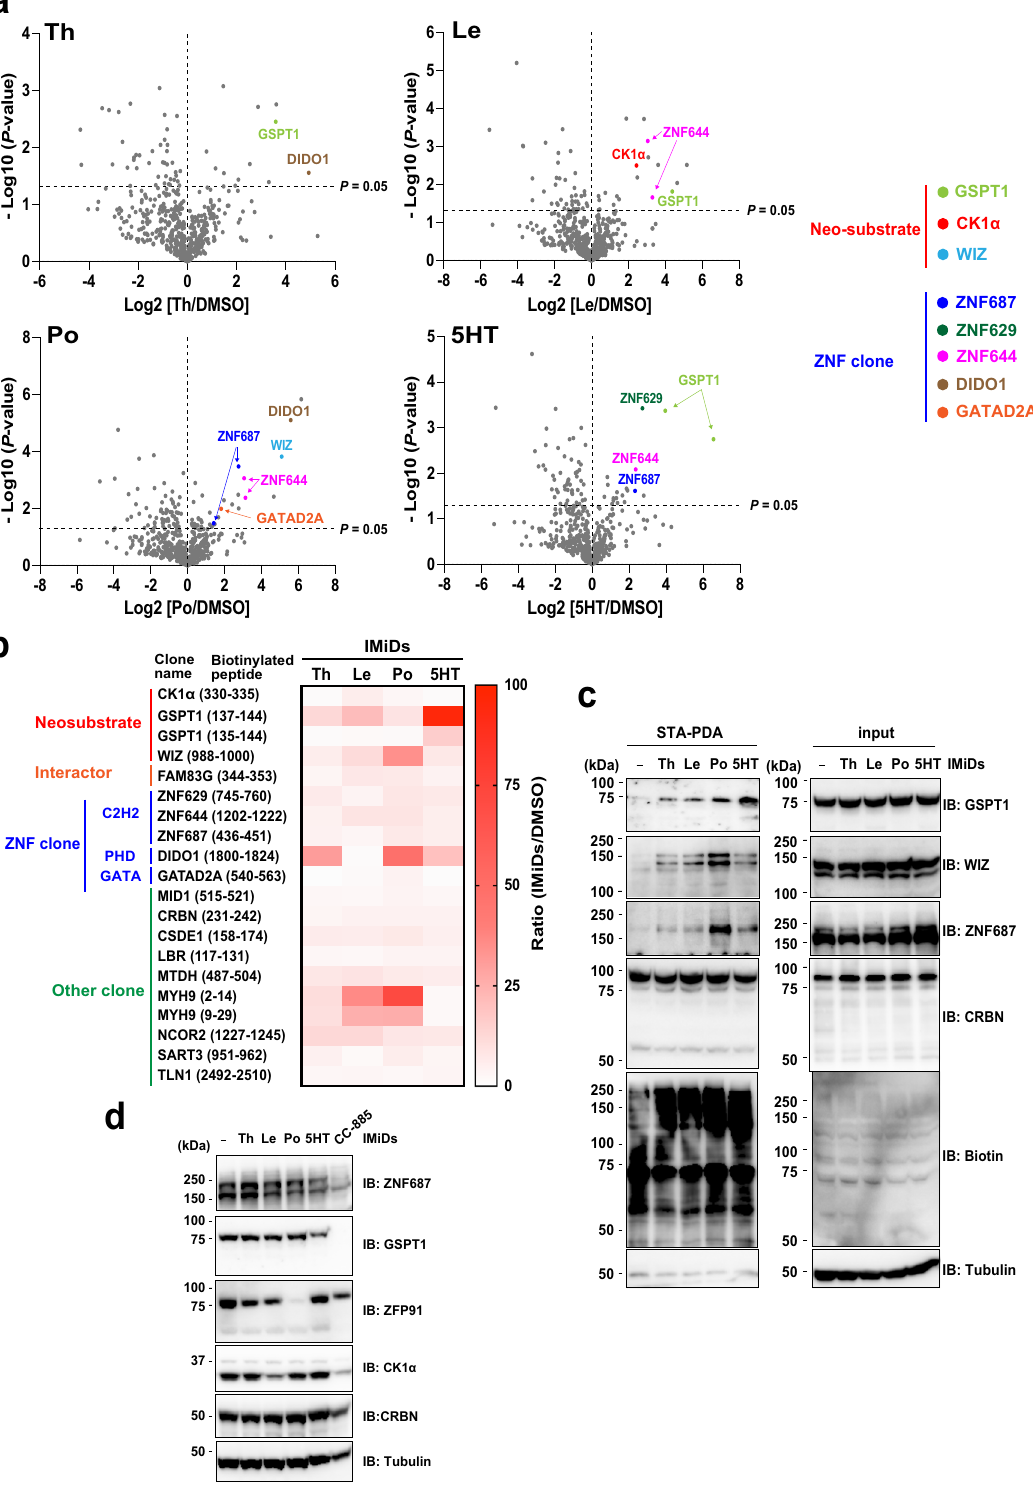
(Fig. 3c). In IMR32 cells, most of the biotinylated proteins were detected among all cell lines used in this study, and eleven pro- teins containing ZNF were detected, including ZNF536, ZNF687 and ZMYM2 (Fig. 3d). We then con fi rmed whether these can- didates were biotinylated in the presence of IMiDs in HuH7 and IMR32 cells. Similar to the results of MS analysis, STA-PDA NATURE COMMUNICATIONS| (2022) 13:183